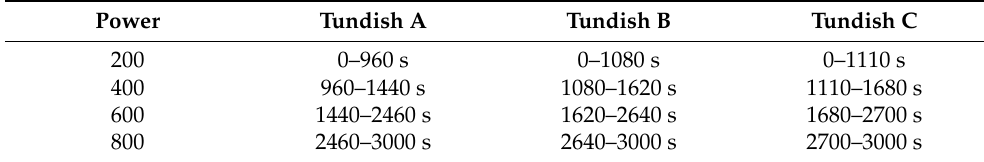
Table 3. Heating power applied in tundishes A, B, and C at different time. Power